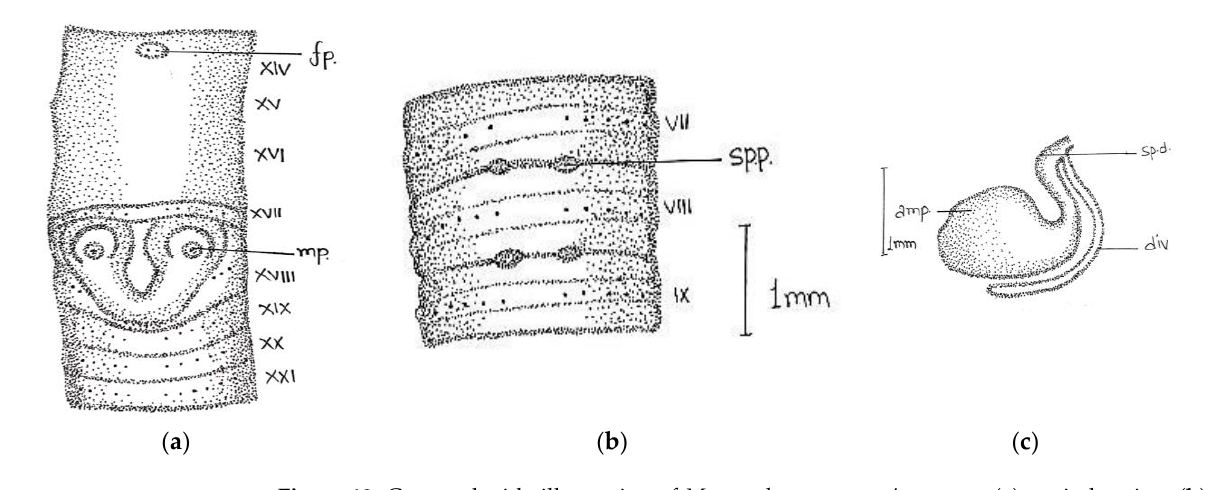
Figure 10. Camera lucida illustration of Megascolex papparensis sp. nov. ( a ) genital region; ( b ) sper- mathecal region; ( c ) spermathecae.